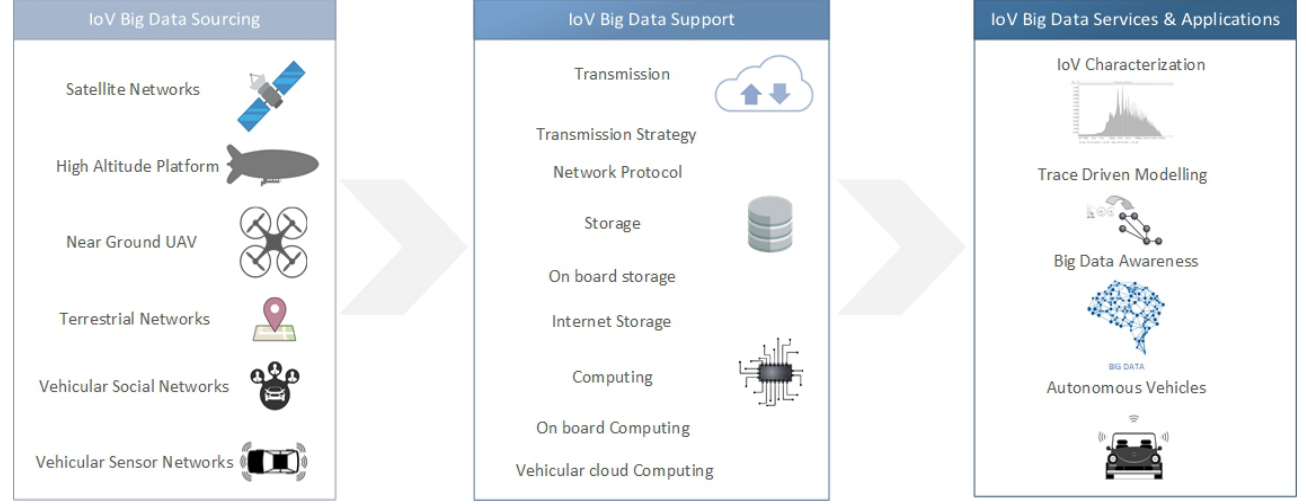
Fig. 3. IoV big data architecture, based on